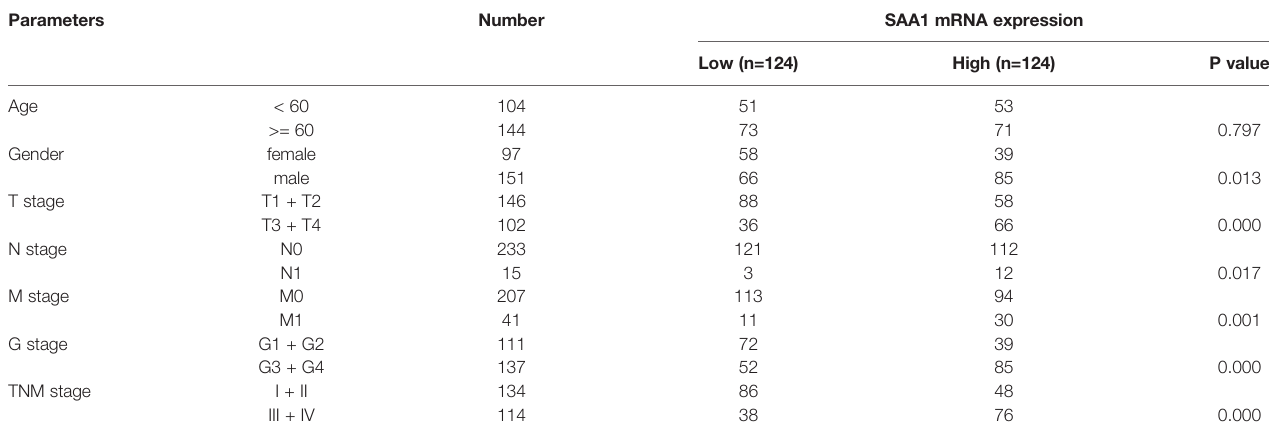
TABLE 1 | Association of SAA1 mRNA expression with clinicopathological parameters in ccRCC patients. Parameters